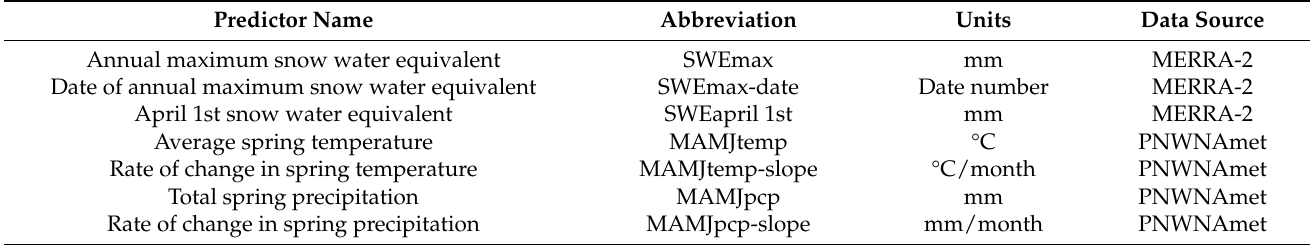
Table 2. Hydroclimatic predictors used in the MLR models to predict AMF and MAMJflow at each of the hydrometric